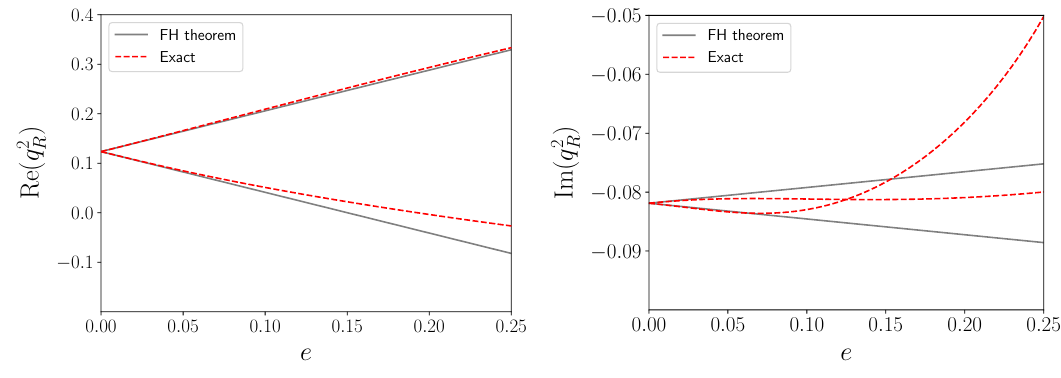
Figure 7 . Verification of the Feynman-Hellmann theorem for the real and imaginary parts of the pole position in the complex plane at ω = 1 . Thin black lines depict the prediction of the